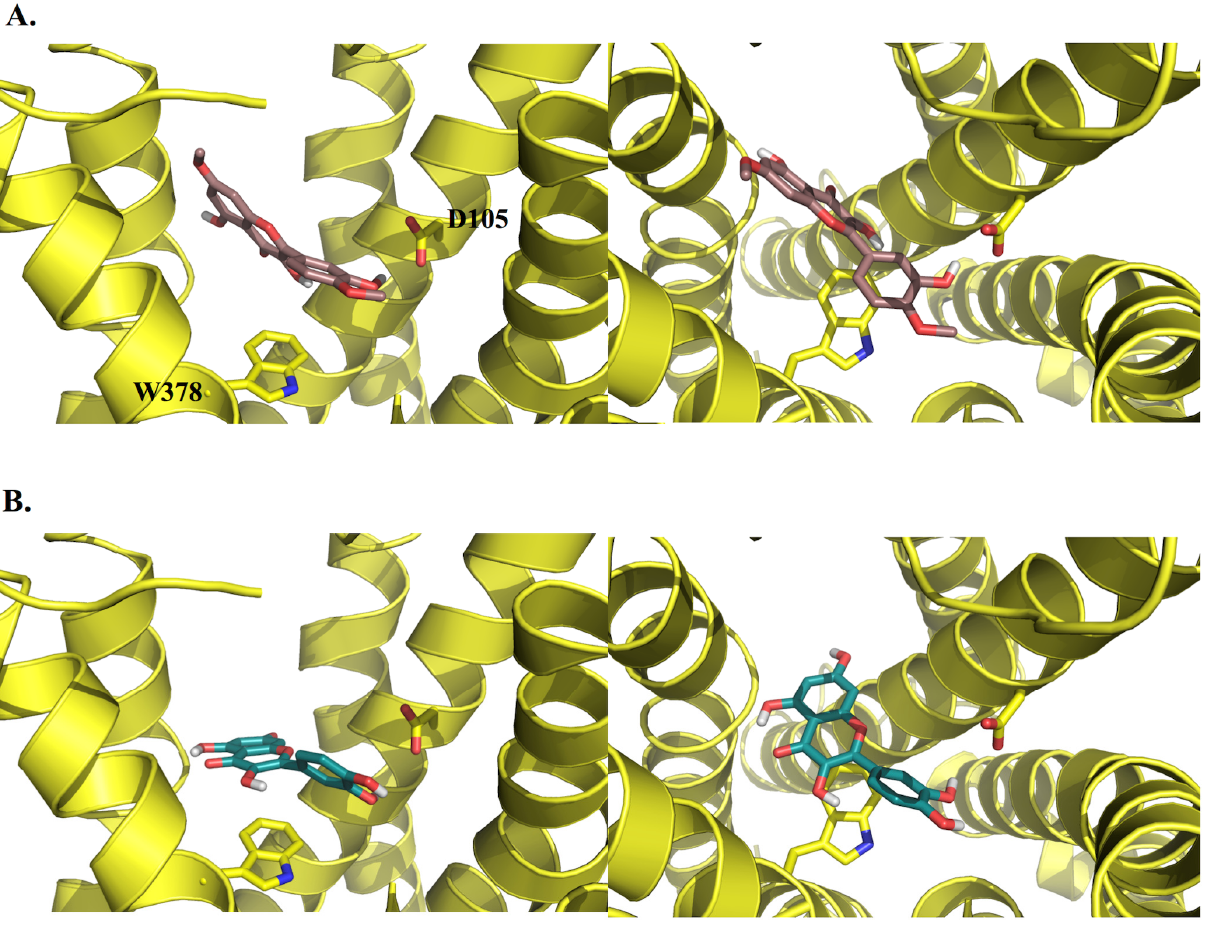
mAChR model obtained 1